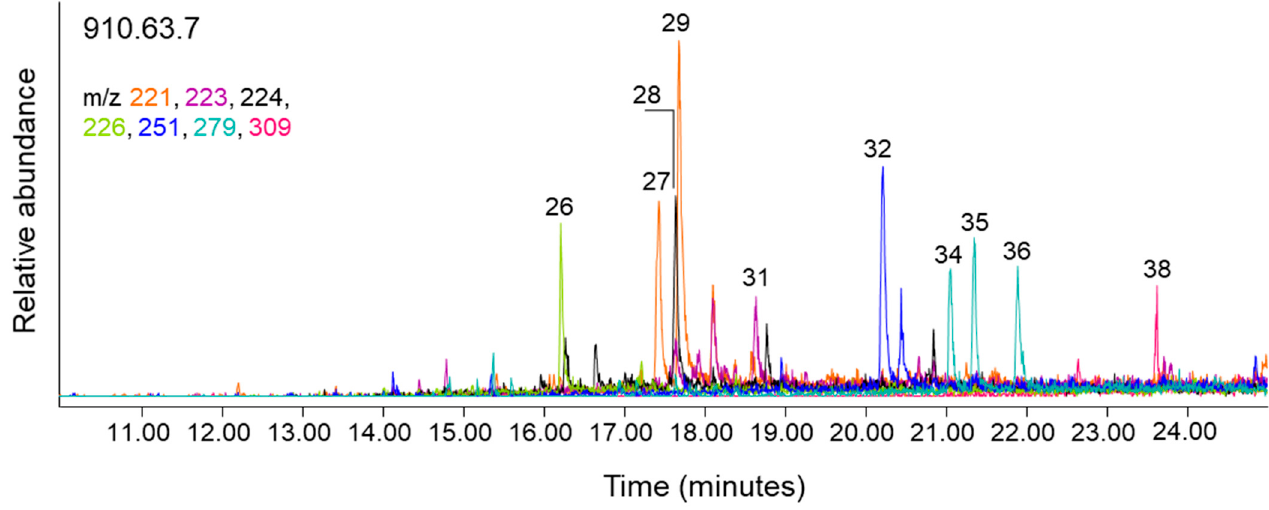
Figure 3. Extracted ion chromatogram (EIC) created using m / z 221, 223, 224, 226, 251, 279, and 309 for cloth 910.63.7. Peak labels correspond to compounds listed in Table 1.